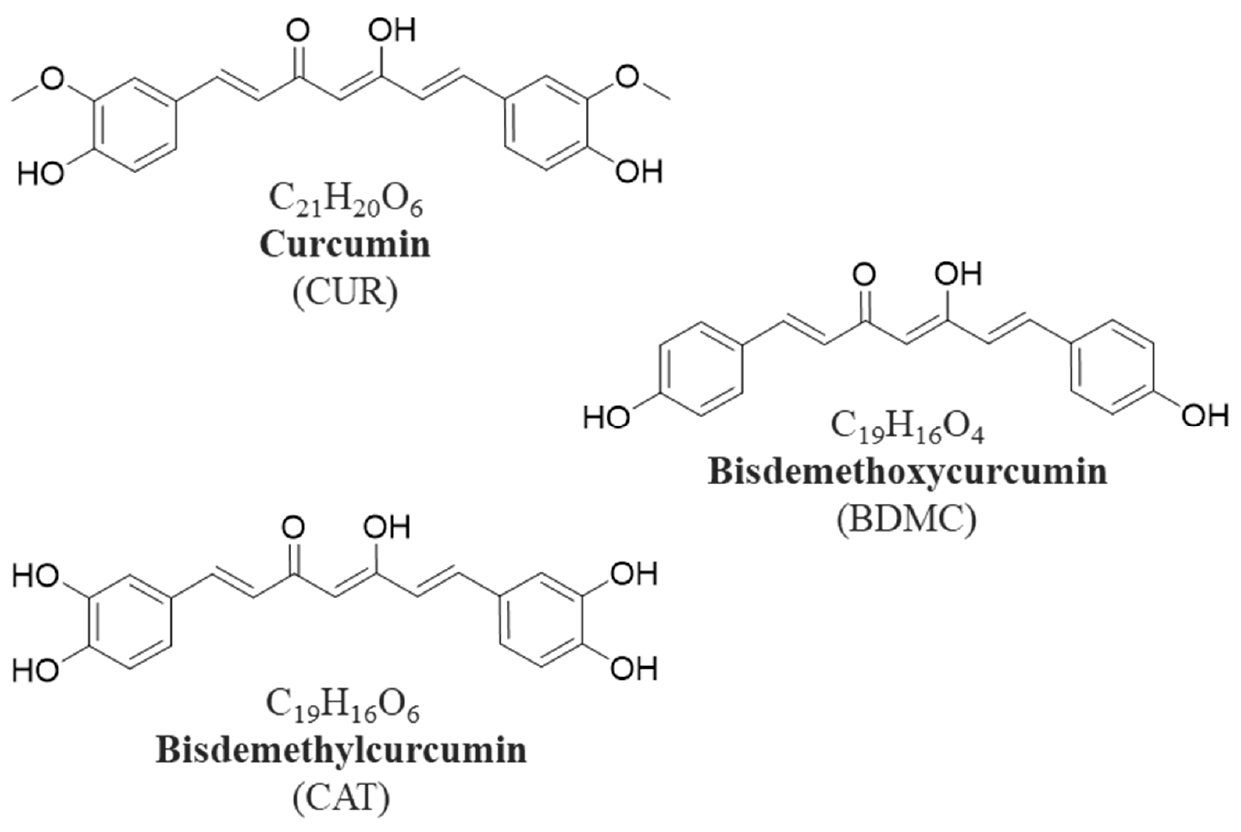
Figure 1. Chemical structures of curcuminoids.